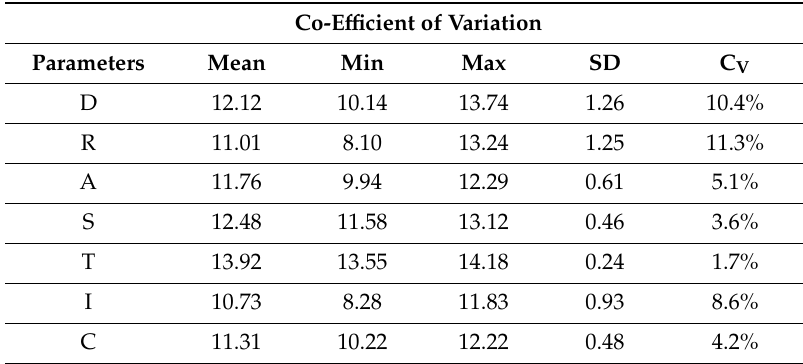
Table 6. Statistics of map removal